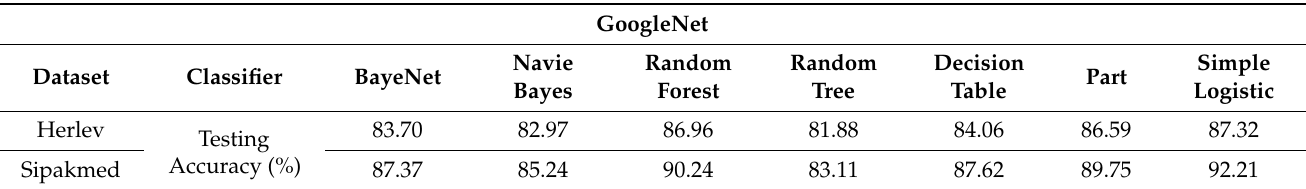
Table 7. Classification accuracy of Googlenet model with machine learning